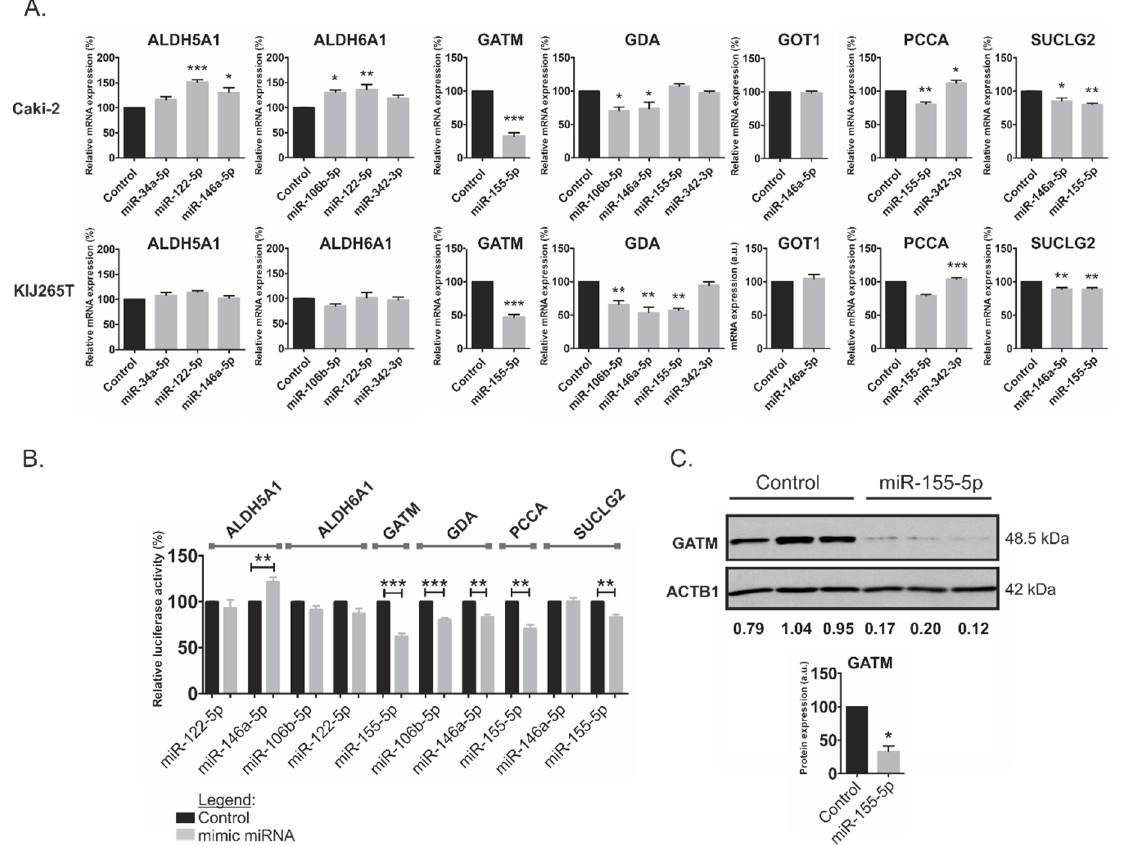
Figure 2. miRNA-mediated regulation of expressions of metabolically relevant genes. ( A ) The effects of miRNAs on mRNA expressions of metabolic genes predicted as potential miRNAs’ targets. Caki-2 and KIJ265T cell lines were transfected using miRNA mimics or non-targeting scrambled control oligonucleotides and expression of target genes was evaluated using qPCR (quantitative real-time PCR). The plots show results of three independent biological experiments (exception: GDA expression in KIJ265T cells): for most miRNAs (except for miR-106b-5p) results of two independent experiments are shown; the expression of GDA in KIJ265T cell line was on the border of detection limit). Statistical analysis was performed using one-way ANOVA with Dunnett’s Multiple Comparison Test, with exception of analysis of GATM and GOT1 for which t-test was used * p < 0.05, ** p < 0.01, *** p < 0.001. ( B) The effects of miRNAs on the activity of luciferase reporter gene under control of cloned miRNA binding sites predicted in metabolic genes. Caki-2 cells were co-transfected with reporter plasmid bearing MRE (miRNA response element) for a given microRNA, and either microRNA mimic or non-targeting scrambled control oligonucleotides. The plots show results of three independent biological experiments. Statistical analysis was performed using Students t-test. ( C ) The effects of miR-155-5p on protein expressions of GATM in Caki-2 cells. Upper panel: Representative photographs of Western blots. Lower panel: Results of densitometric scanning of Western blots. The plot shows mean expression of GATM protein in three independent biological experiments performed in two-three replicates. * p < 0.05.